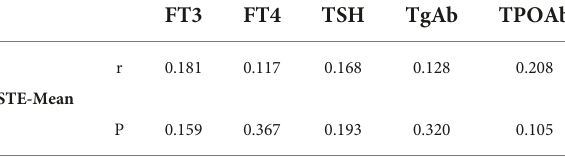
TABLE 2 Correlation between STE-Mean value and serum indexes.